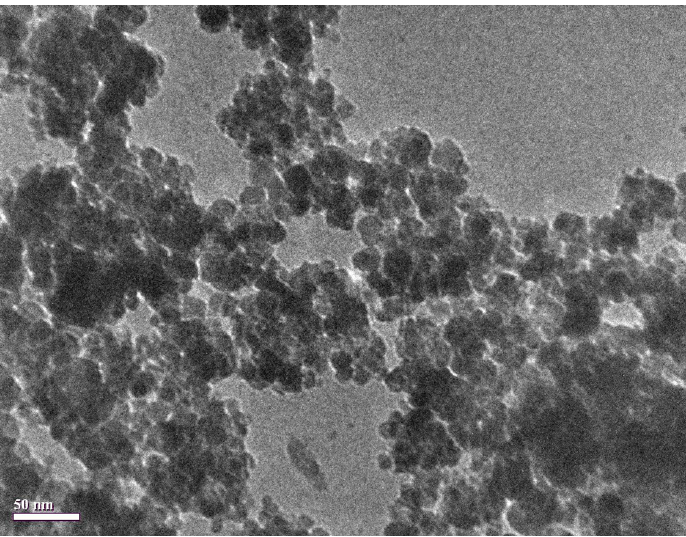
Figure 3. Transmission electron microscope (TEM) image of synthesized Fe 3 O 4 nanoparticles.